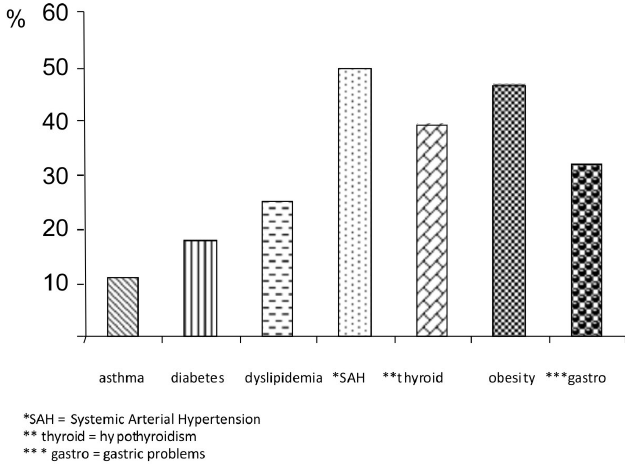
FIGURE 1 - Frequency of clinical comorbidities. to treatment, five (55.6%) passed to have good